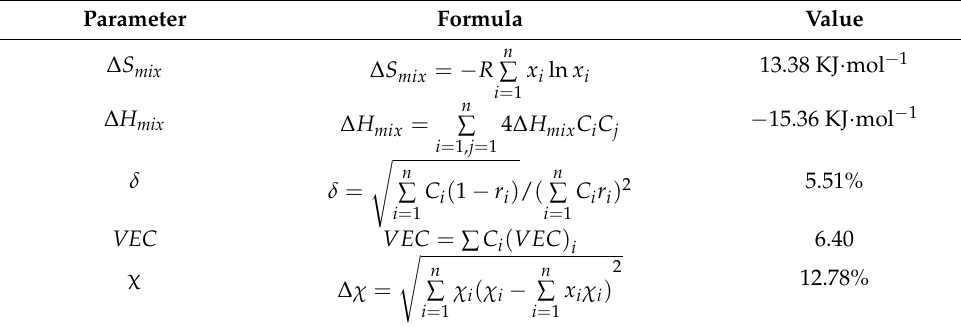
Table 1. The relative parameters to predict the structure of AlCrFeNiV. Parameter